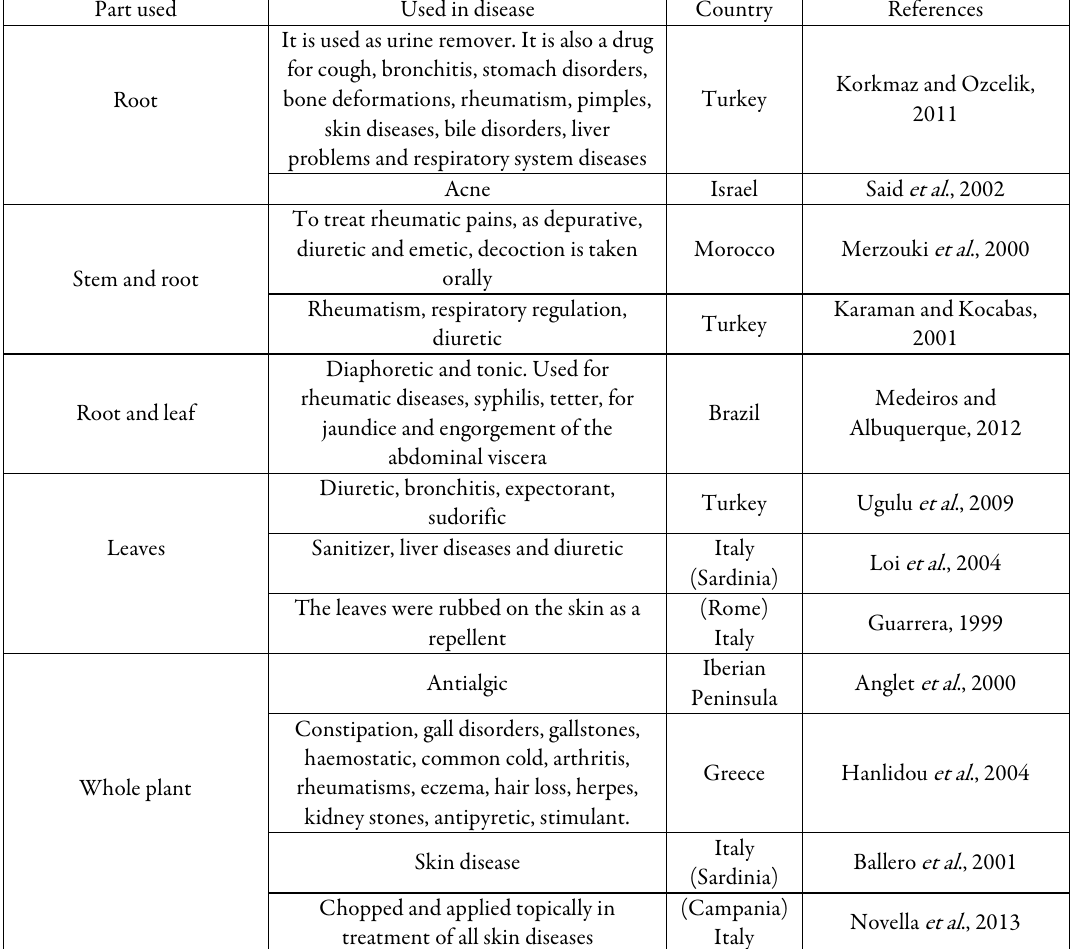
Table 1. Traditional medicinal uses of the Saponaria officinalis